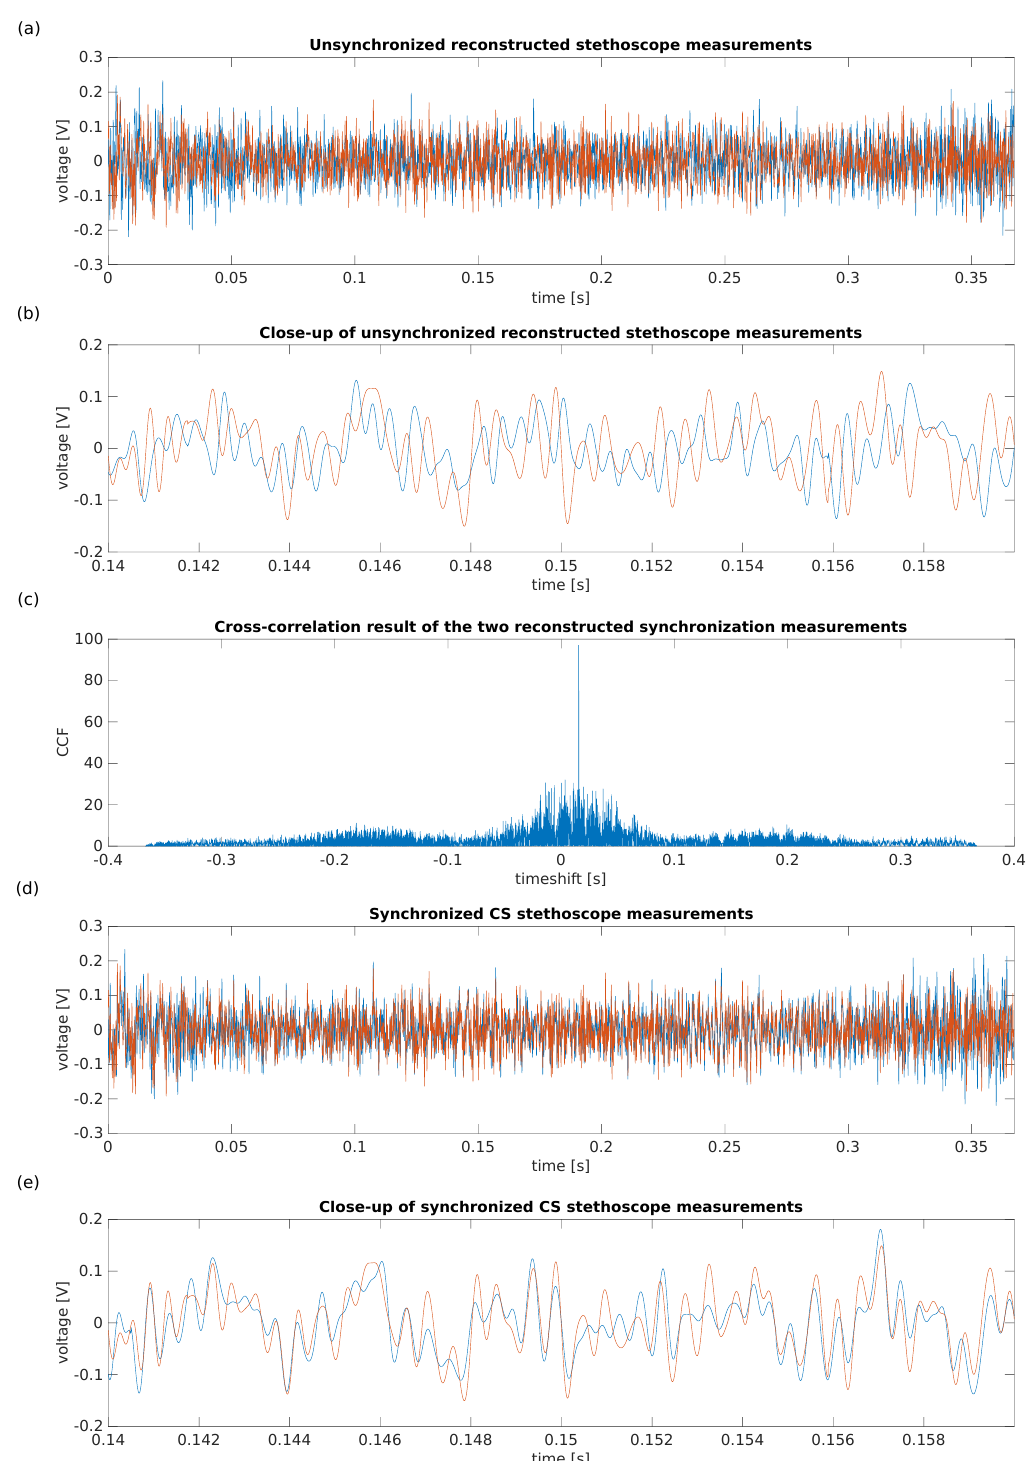
Figure 6. Summary of the results of the CS synchronization setup. Subfigure ( a ) presents a reconstruc- tion of the undersampled stethoscope measurements with an undersampling factor n of 3. Subfigure ( b ) is a close-up of the above signal, to clearly demonstrate that the signals are out of sync. Subfigure ( c ) is the result of the cross-correlation of the two synchronization block pulse captures. This is used to determine the offset between the starting time of both captures, and then synchronize the two diastolic sound captures. In subfigure ( d ) the result of this synchronization shift is presented, whereas subfigure ( e ) offers a closer look on the synchronized